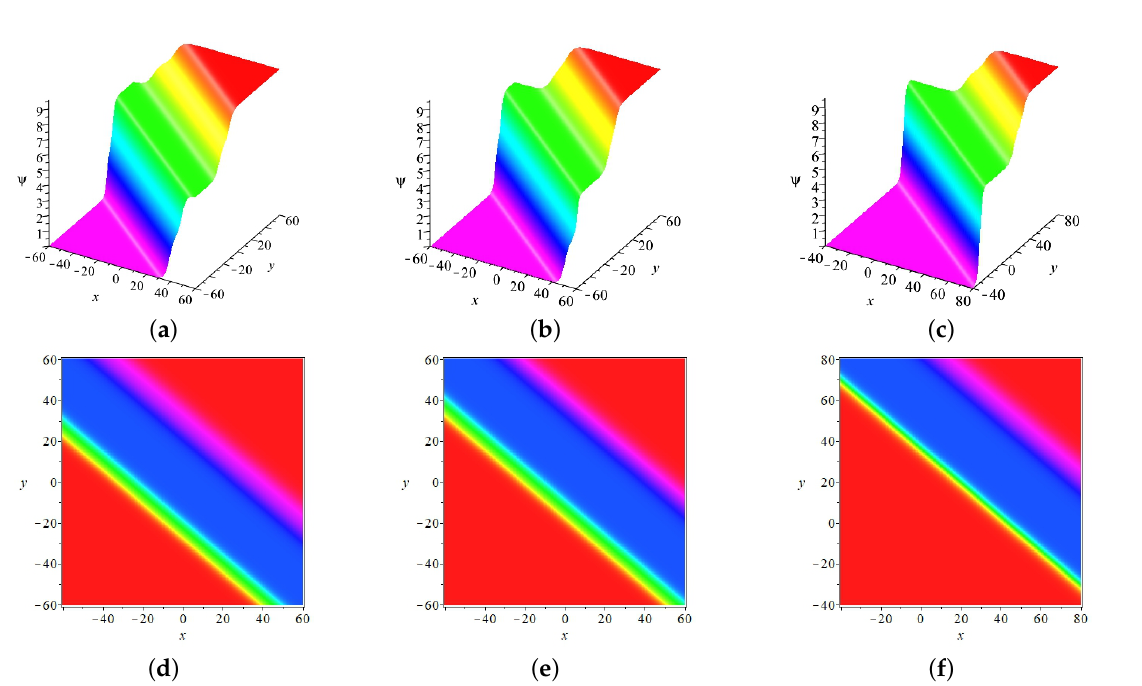
Figure 13. (Color online) The molecular state between the quasi-kink soliton and quasi-kink soliton with r 2 = r 3 = r 4 = r 6 = r 7 = r 8 = 1, β 1 = β 3 = 2, κ 1 = κ 2 = 0, a 1 = 0.5, b 1 = 0.005, c 1 = 1.2, d 1 = 0, e 1 = 0.5, f 1 = − 3.5, γ 1 = 10, a 2 = 0.3, b 2 = 0.003, c 2 = 1.2, d 2 = 0, e 2 = 0.542, f 2 = − 3.5, γ 2 = − 10. ( a – c ) are vertical view when t = − 30, t = 0 and t = 30. ( d – f ) are contour plots of ( a – c ),